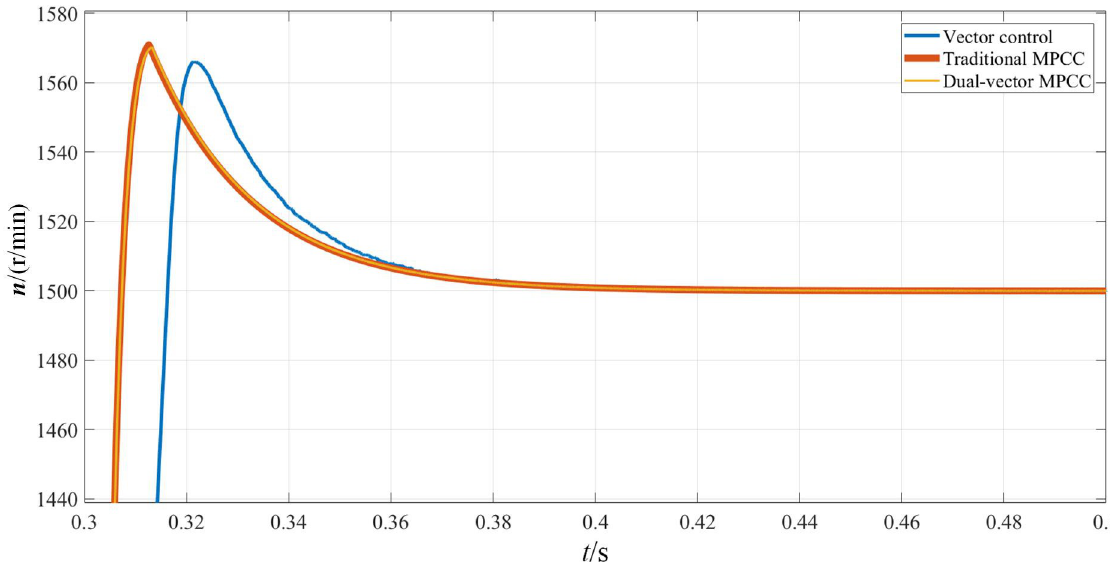
Fig 13. Rotational speed waveform when the given speed changes.